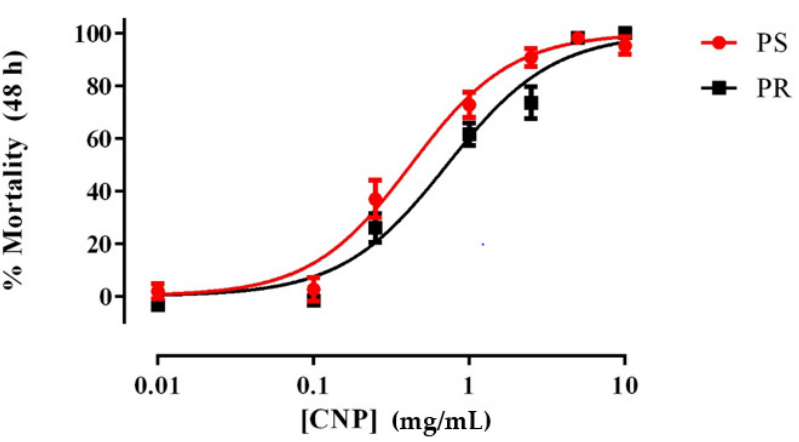
Figure 1. Concentration-response curves for acute toxicity (48 h) of E1800 against 1st instar Ae. aegypti of representative pyrethroid-susceptible (PS, red) and pyrethroid-resistant (PR, black) strains. Values plotted are means ± standard errors of the mean based on 12 replicates of 5 larvae per concentration (Control average PS: 2.5%; PR: 3.87%). The median lethal concentration (LC 50 ) value of the PR strain (0.72 mg/mL) was significantly greater (F-test, p < 0.001) than that of the PS strain (0.42 mg/mL) as determined using a nonlinear regression fit and a F-Test ( p < 0.001). Mortality values were corrected using Abbott´s formula [40] .